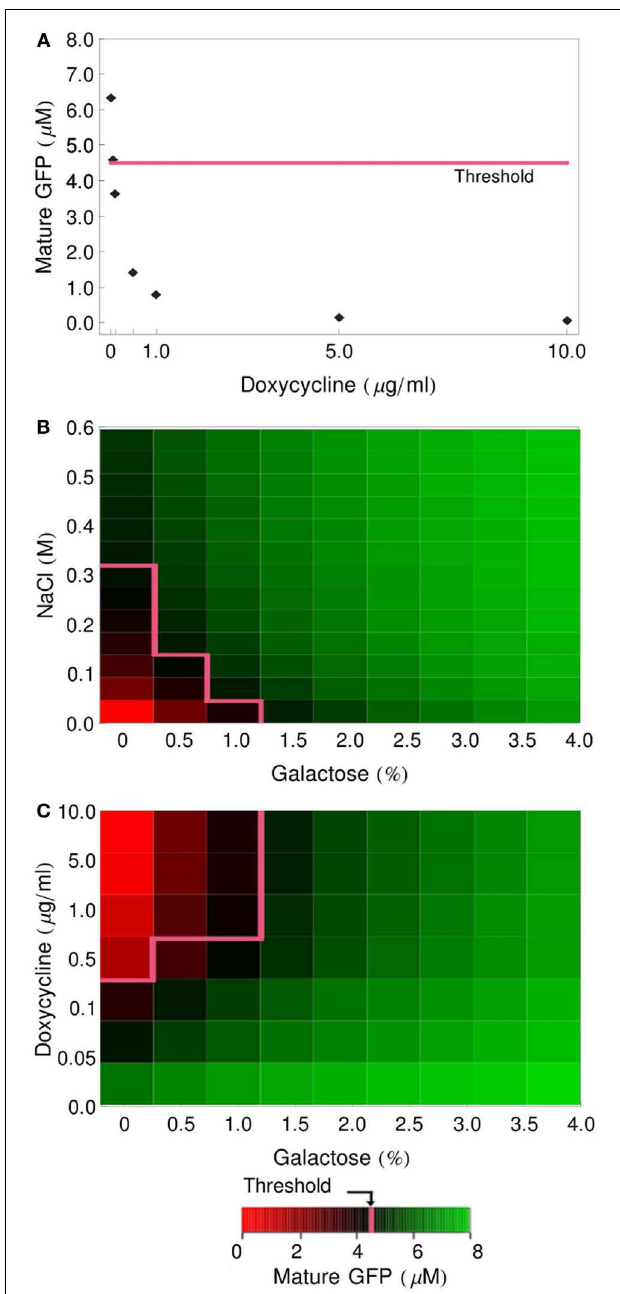
FIGURE 5 | Influence of pre-accumulation of alpha-factor mRNA and precursors in gal- and dox-cells on gate functioning. Initial concentrations of MFalpha1-mRNA and prepro-Alpha in gal - and dox-cells were set to 0 and simulations were performed as in Figure 4 . (A) GFP produced by the NOT gate. (B) GFP production in the OR gate. (C) GFP production in the IMPLIES gate.The pink line depicts the GFP threshold of 4.5 µ